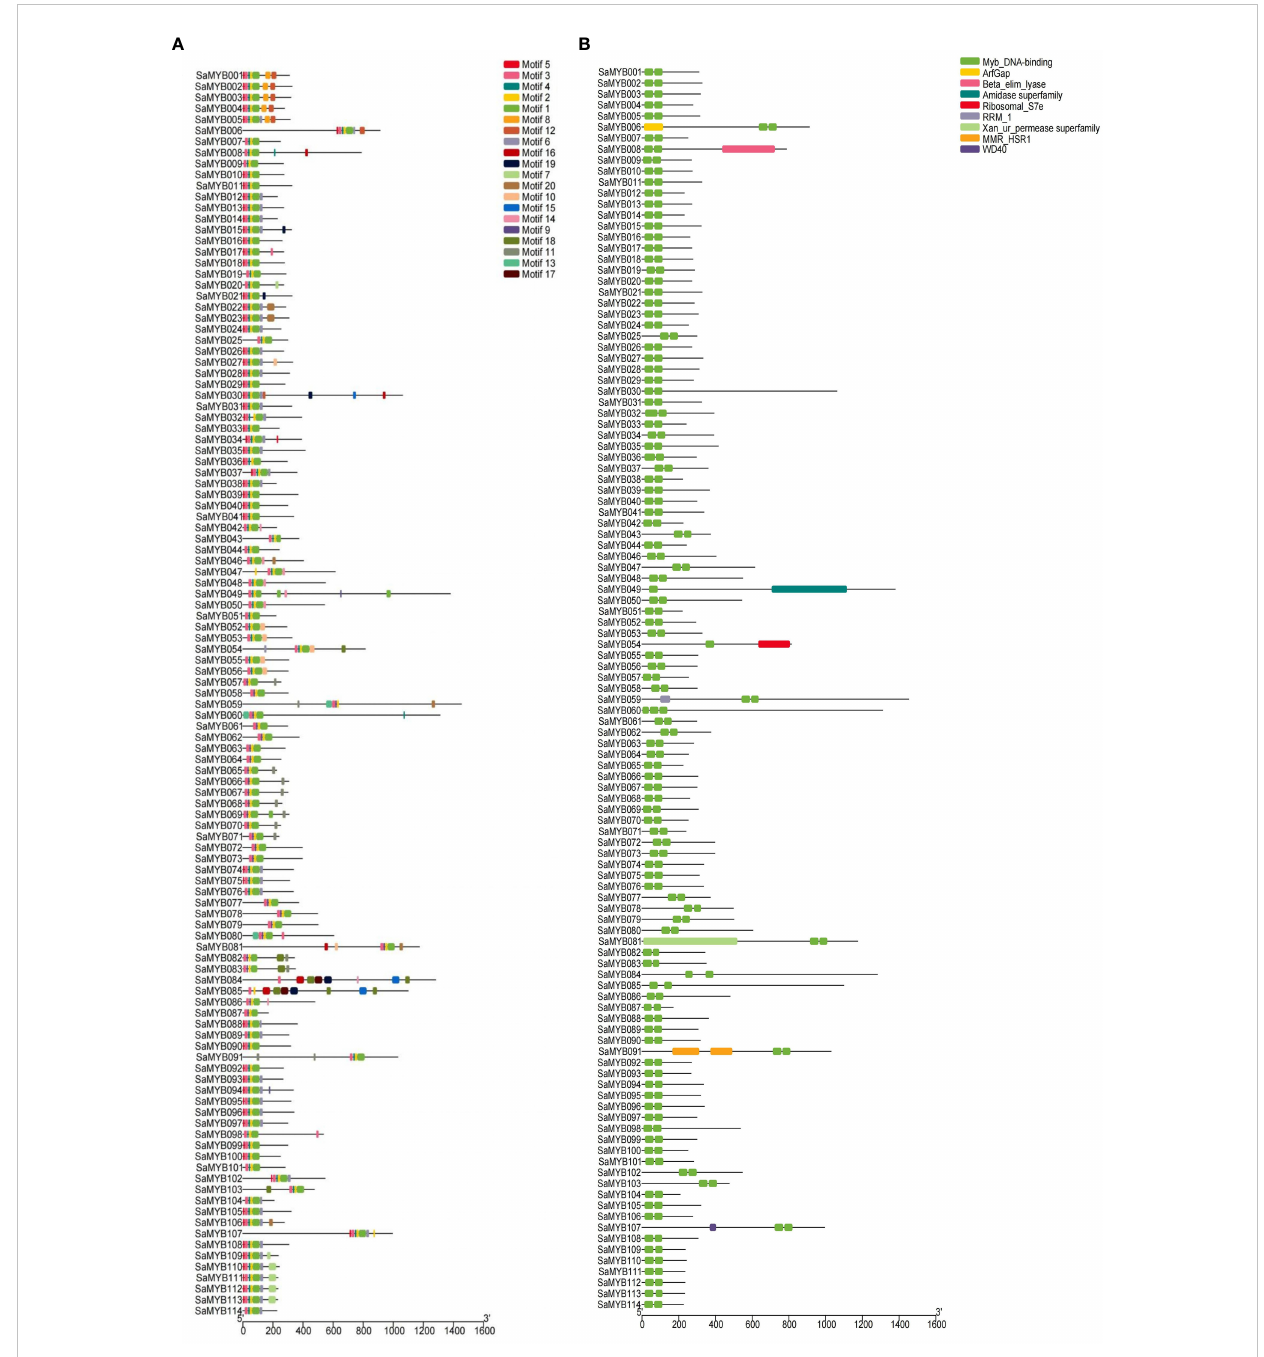
FIGURE 3 Conserved motif analyses of the 114 R2R3-MYB genes in S. album . (A) The left panel shows the results of conserved motif analysis. A total of 20 predicted motifs are represented by different colored boxes. (B) The right panel shows the conserved domains in the 114 R2R3-MYB genes with different colors representing the different types of